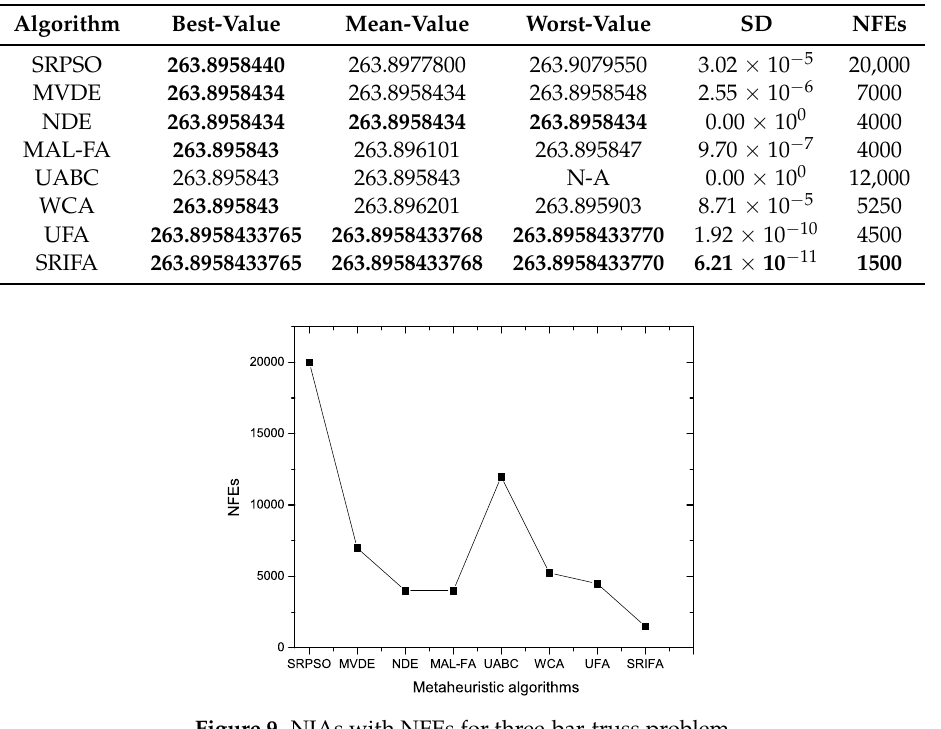
Figure 9. NIAs with NFEs for three-bar-truss